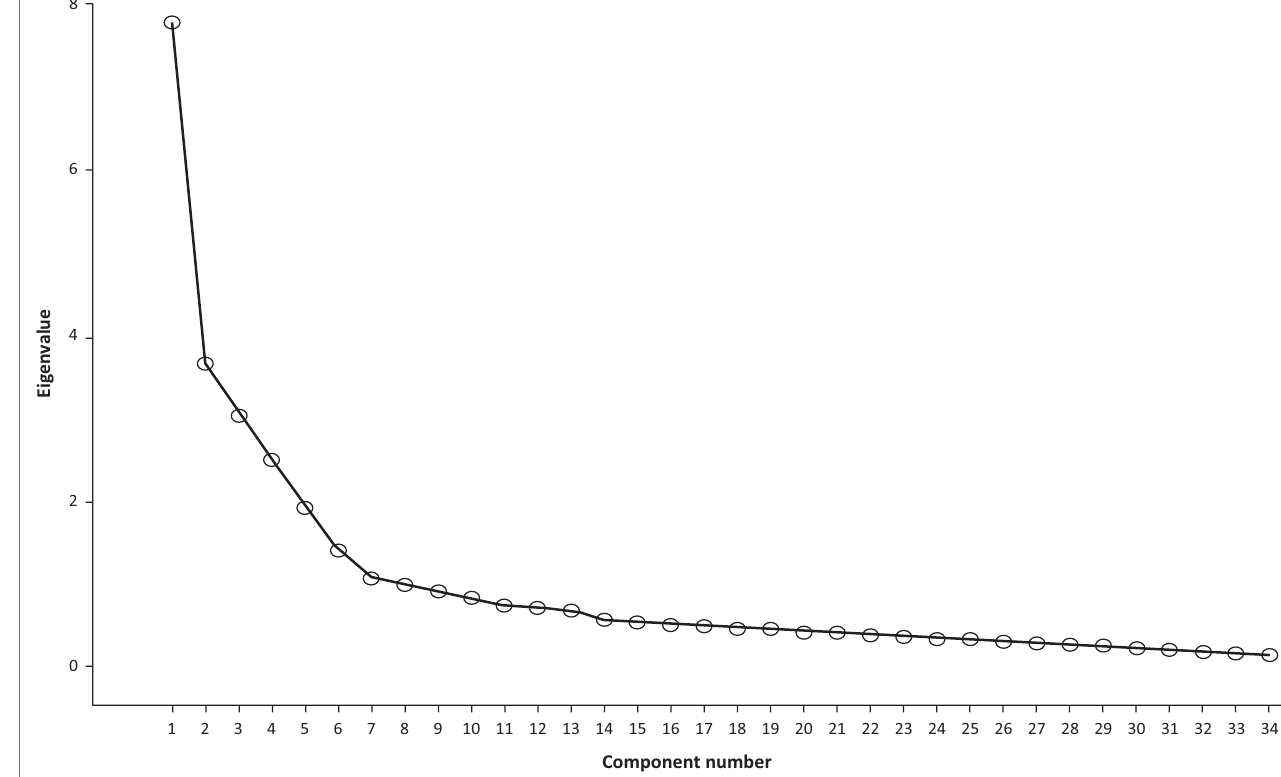
FIGURE 1: Cattell’s scree plot for the NEO-PI-3 and Horizontal–Vertical I/C